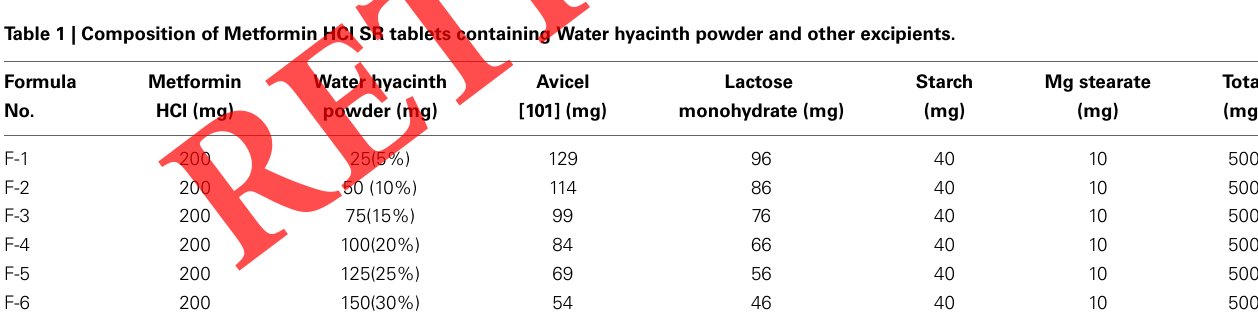
FIGURE 1 | Water hyacinth processing